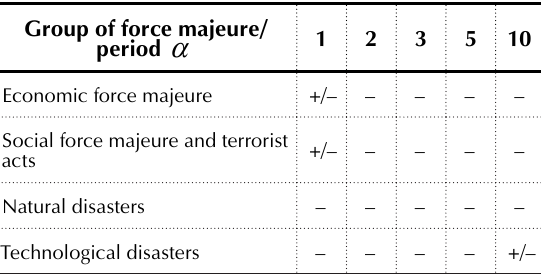
Table 19. Overall results for Hypothesis